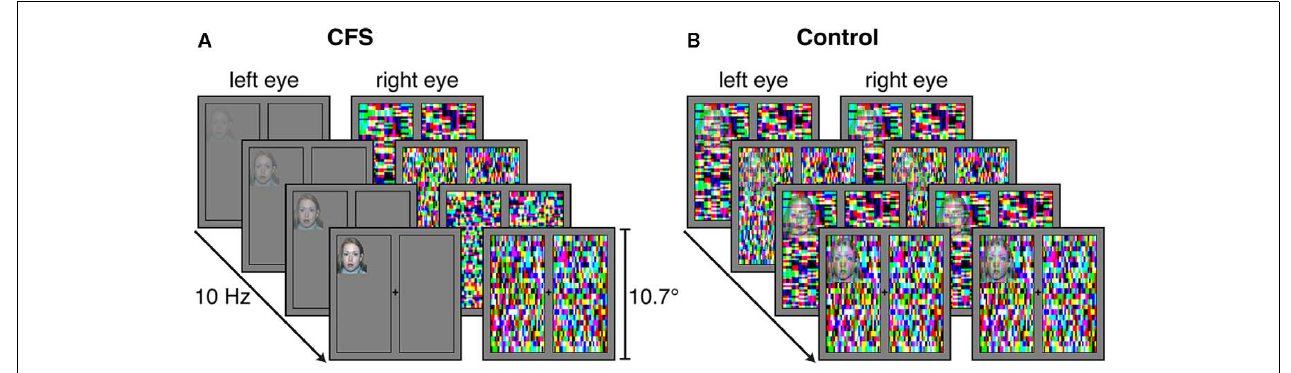
Experiments 1 and 2, participants were asked to indicate as fast and accurately as possible on which side of fixation the face or any part of the face became visible. In Experiment 3, presentation durations were fixed and subjects were required to indicate as accurately as possible, without speed pressure, on which side of fixation the face was